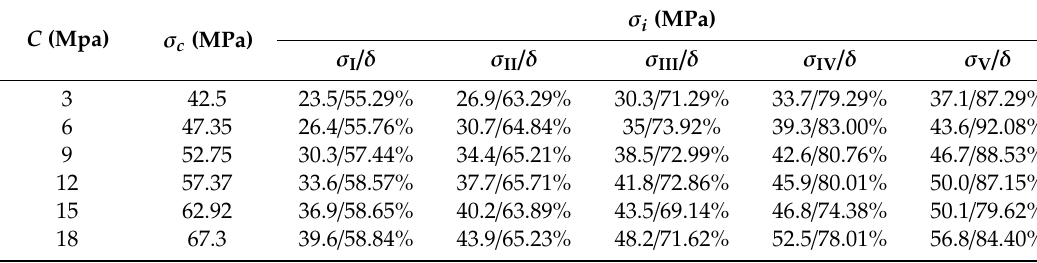
Table 2. Multi-stage loading for creep tests of